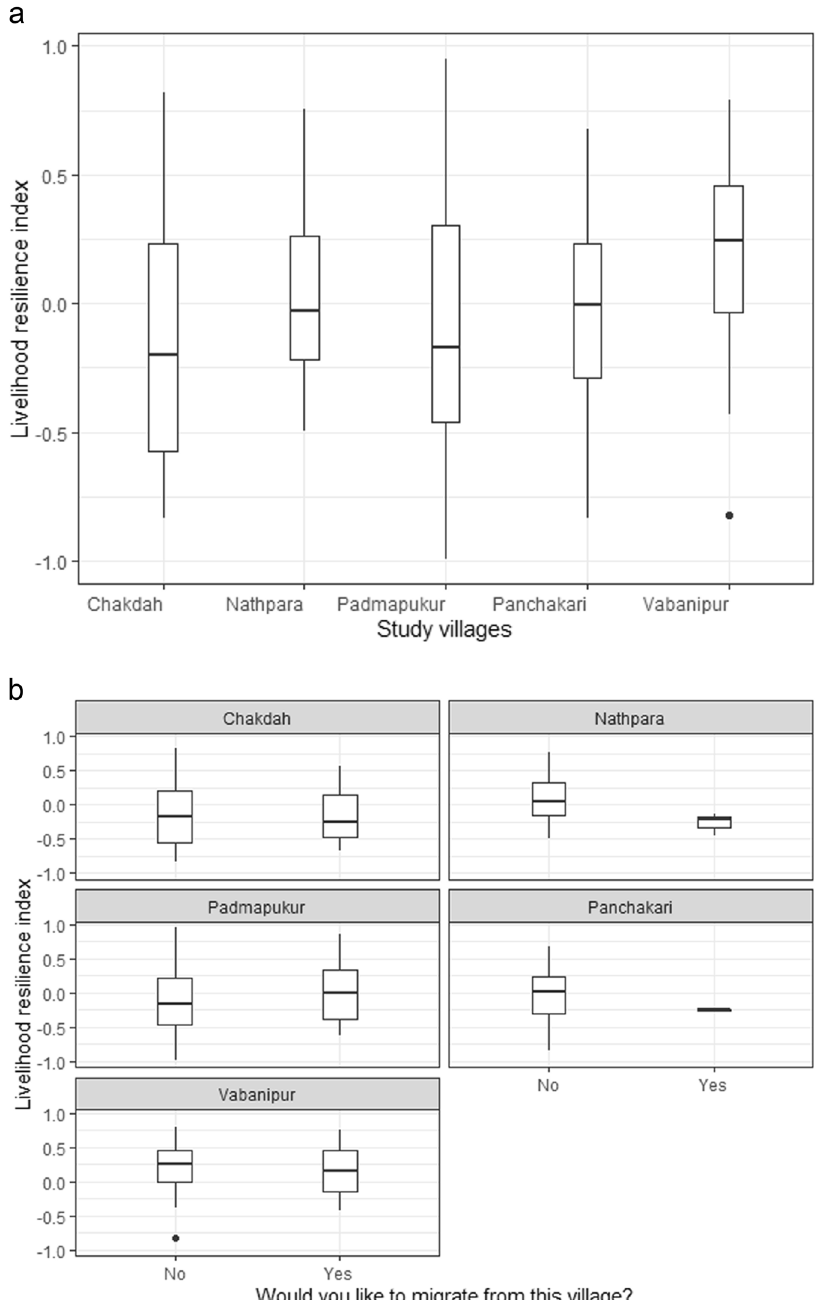
Fig. 4 Livelihood resilience index and migration across the villages. a Livelihood resilience index across villages. b Migration aspiration, livelihood resilience index across villages. Source: Field survey